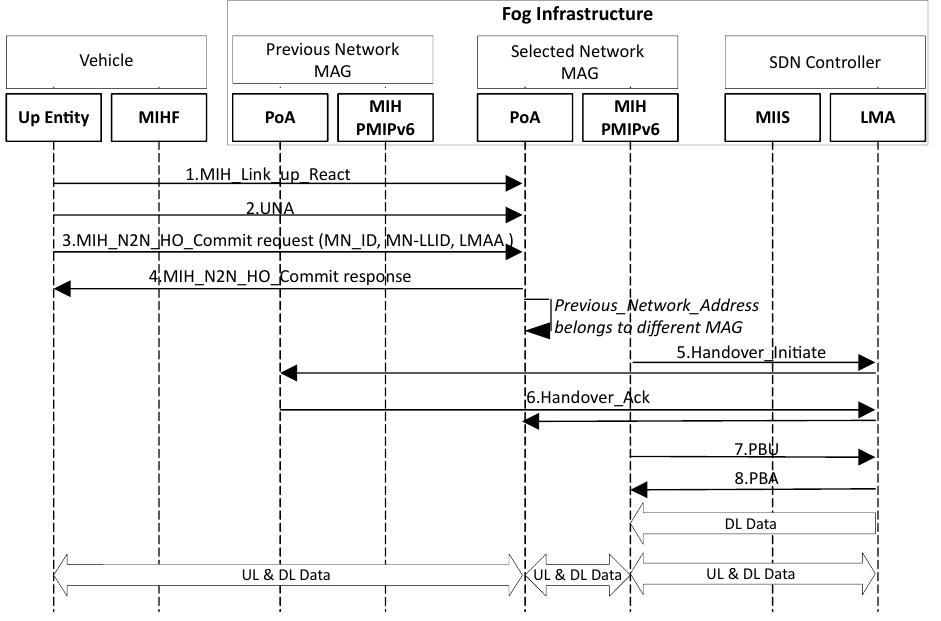
Figure 11. The inter-MAG reactive VHO signaling.